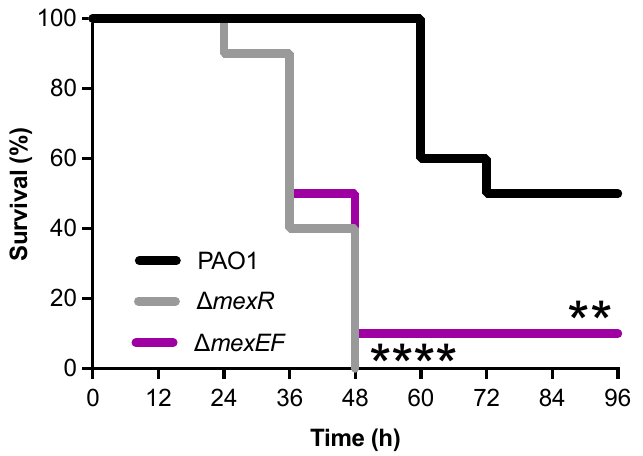
Figure 3. MexAB-OprM overexpression and MexEF-OprN deletion exhibit increased in vivo virulence. Both Δ mexR and Δ mexEF mutations in WT PAO1 significantly reduce mouse survival during an acute lung infection compared to WT PAO1 (WT). Survival times were tested across strata with a Bonferroni-adjusted log-rank test: ** p < 0.005 and **** p < 0.0001 compared to WT PAO1, n = 10 mice/group.